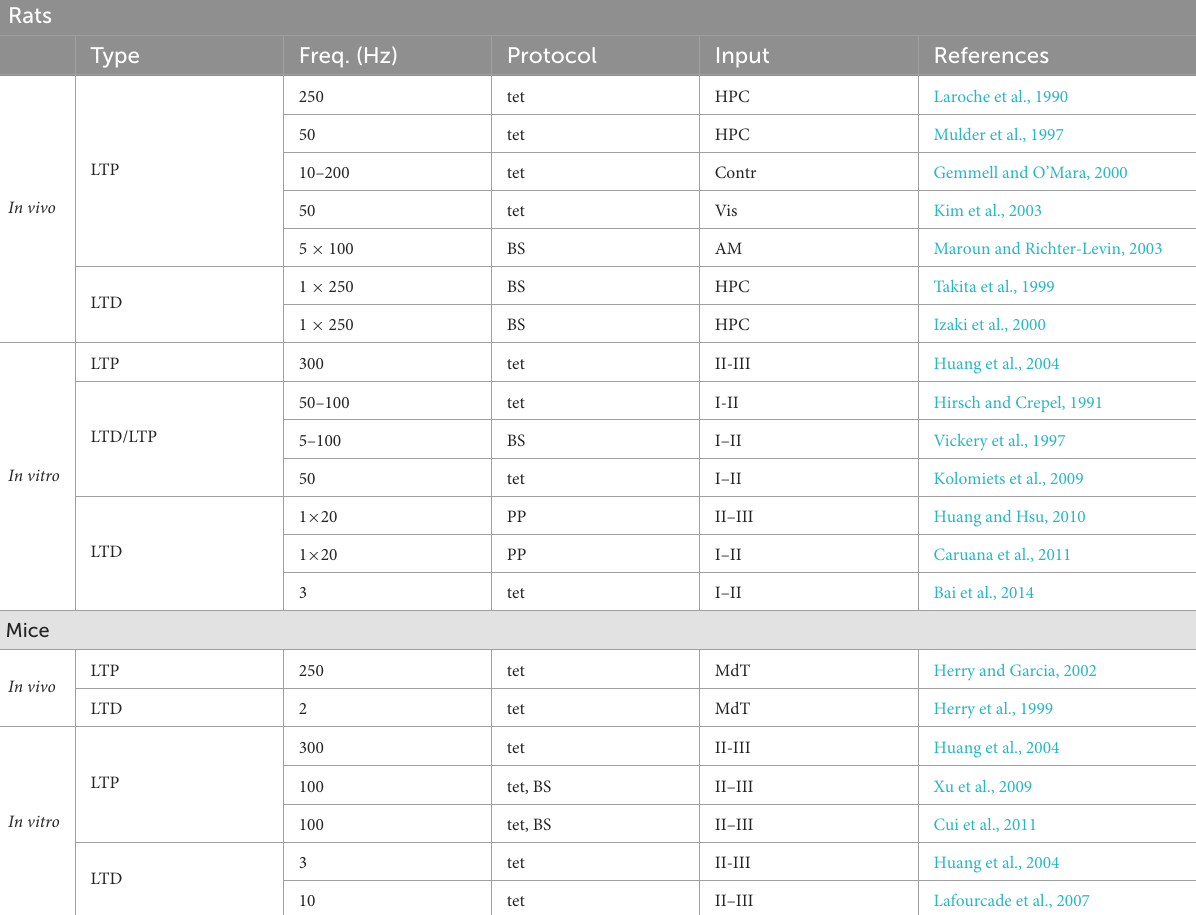
TABLE 1 Experimental studies on long-term synaptic plasticity in rodent PFC.